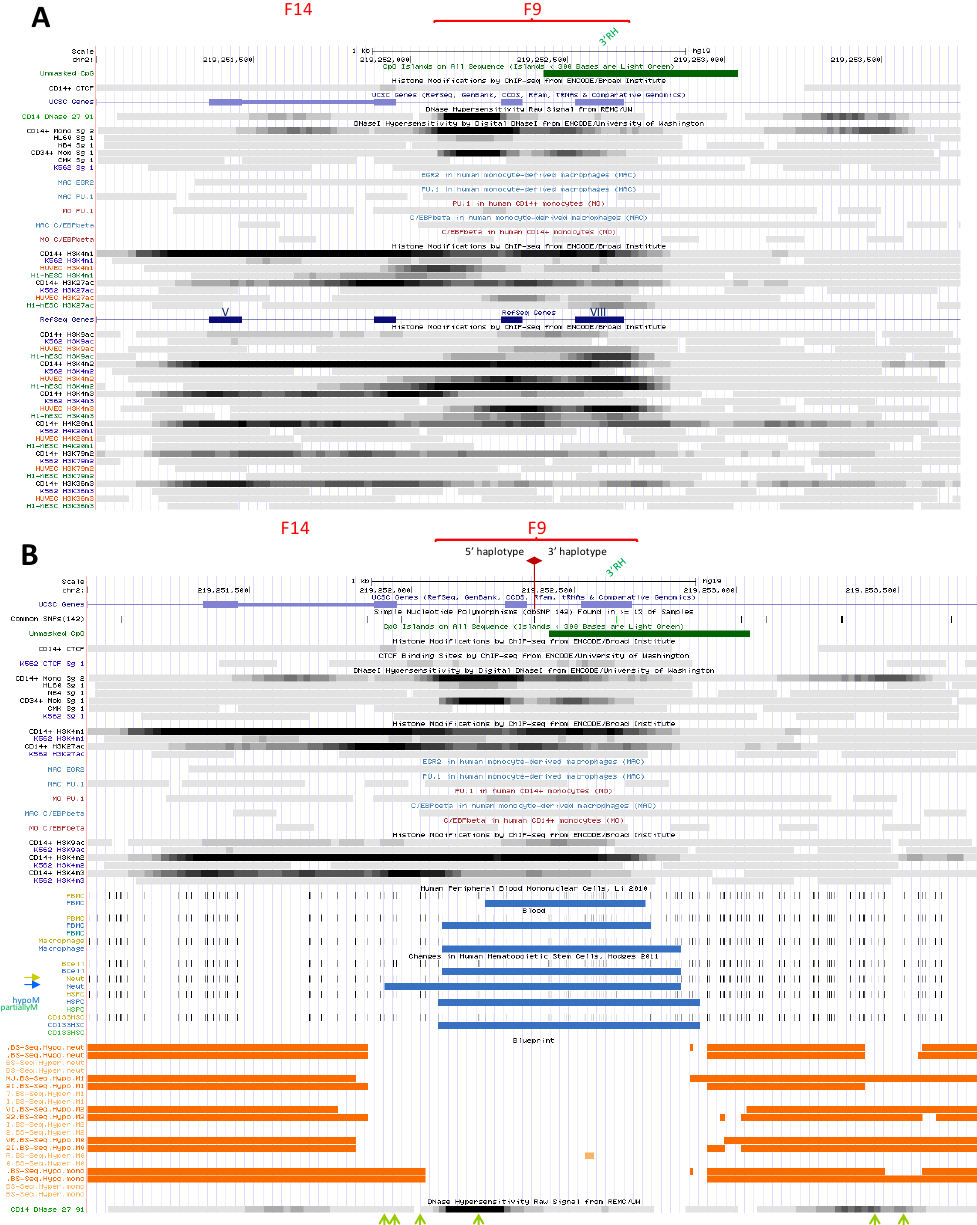
Figure 5. Epigenetic modifications at NRAMP1 locus region iv, encompassing Dnase1 footprints F14 and F9 (described in text sections: 2.3.1.4 and 2.3.1.5, respectively). ( A ) same as Figure 2. ( B ) same as Figure 2; the boundary of NRAMP1 5′ and 3′ haplotypes is indicated (cf section 2.3.5).